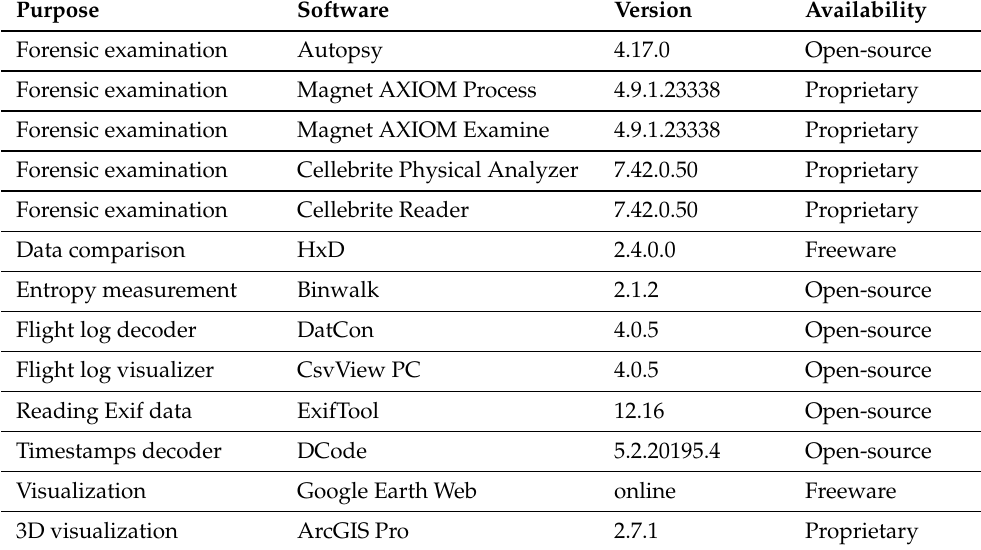
Table 1. A set of tools used to conduct our